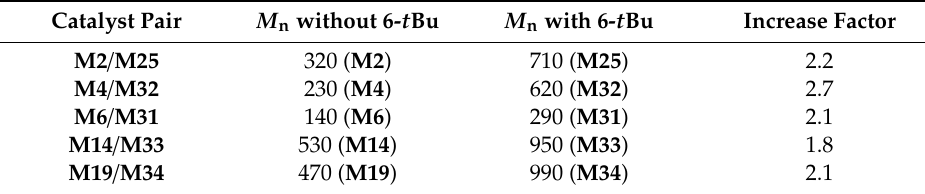
Table 5. E ff ect of a 6- t Bu substituent on PP M n (in